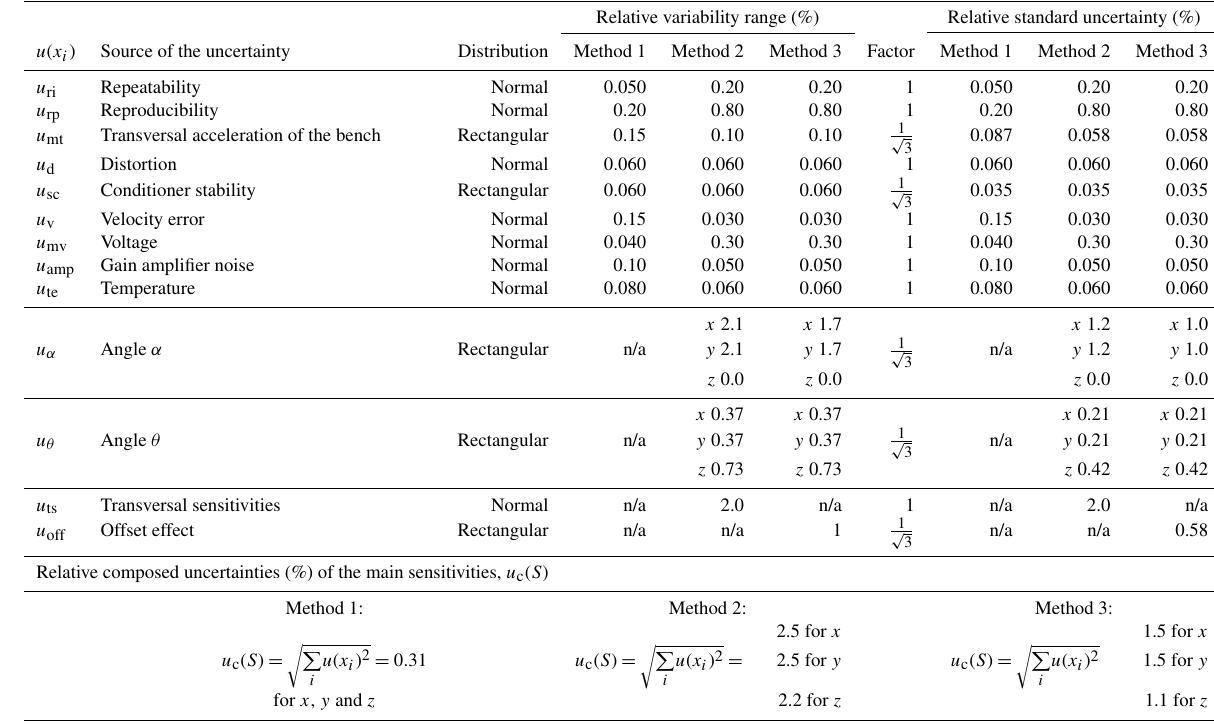
Relative variability range (%) Relative standard uncertainty (%)